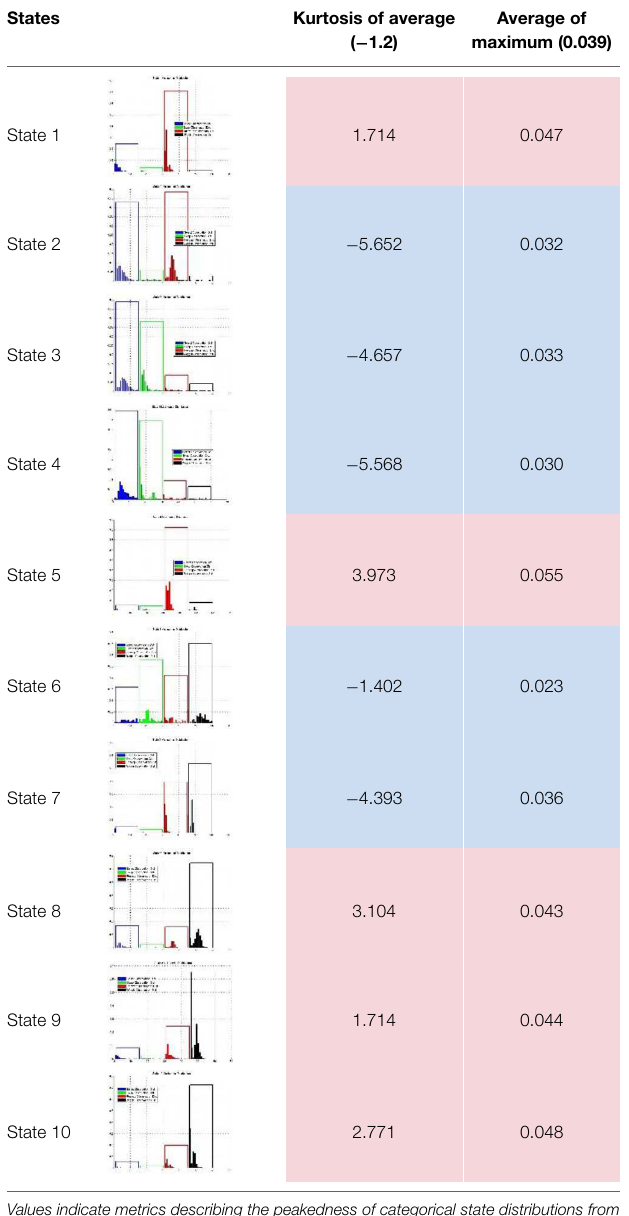
TABLE 5 | Classification of states based on kurtotic qualities of categorical distributions. States Kurtosis of average